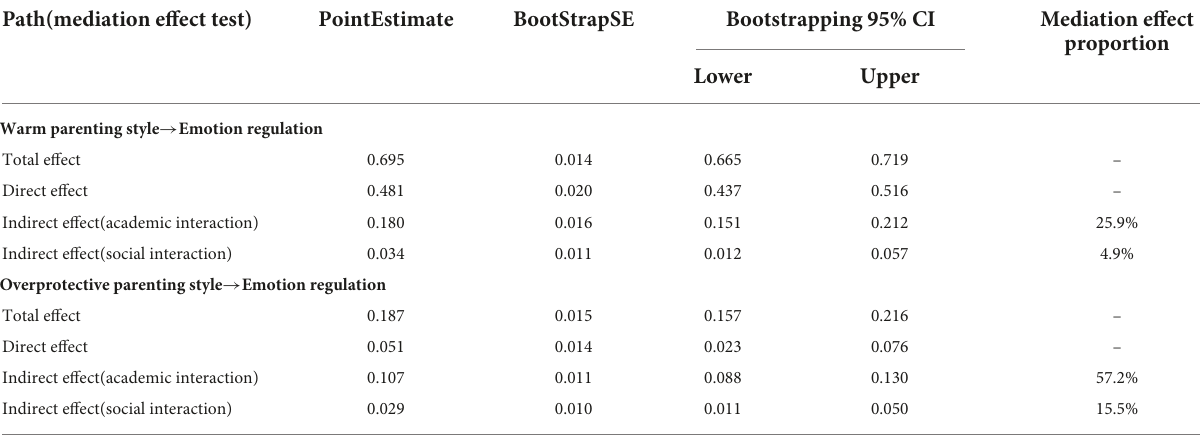
TABLE 5 Intermediary effects